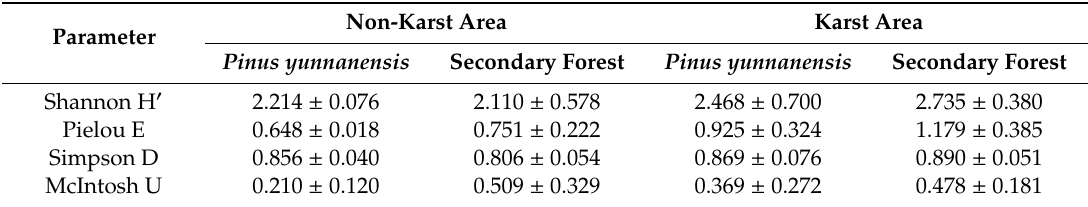
Table 3. Diversity indicators of the soil microbial community under different forests in non-karst and karst areas of southern China.